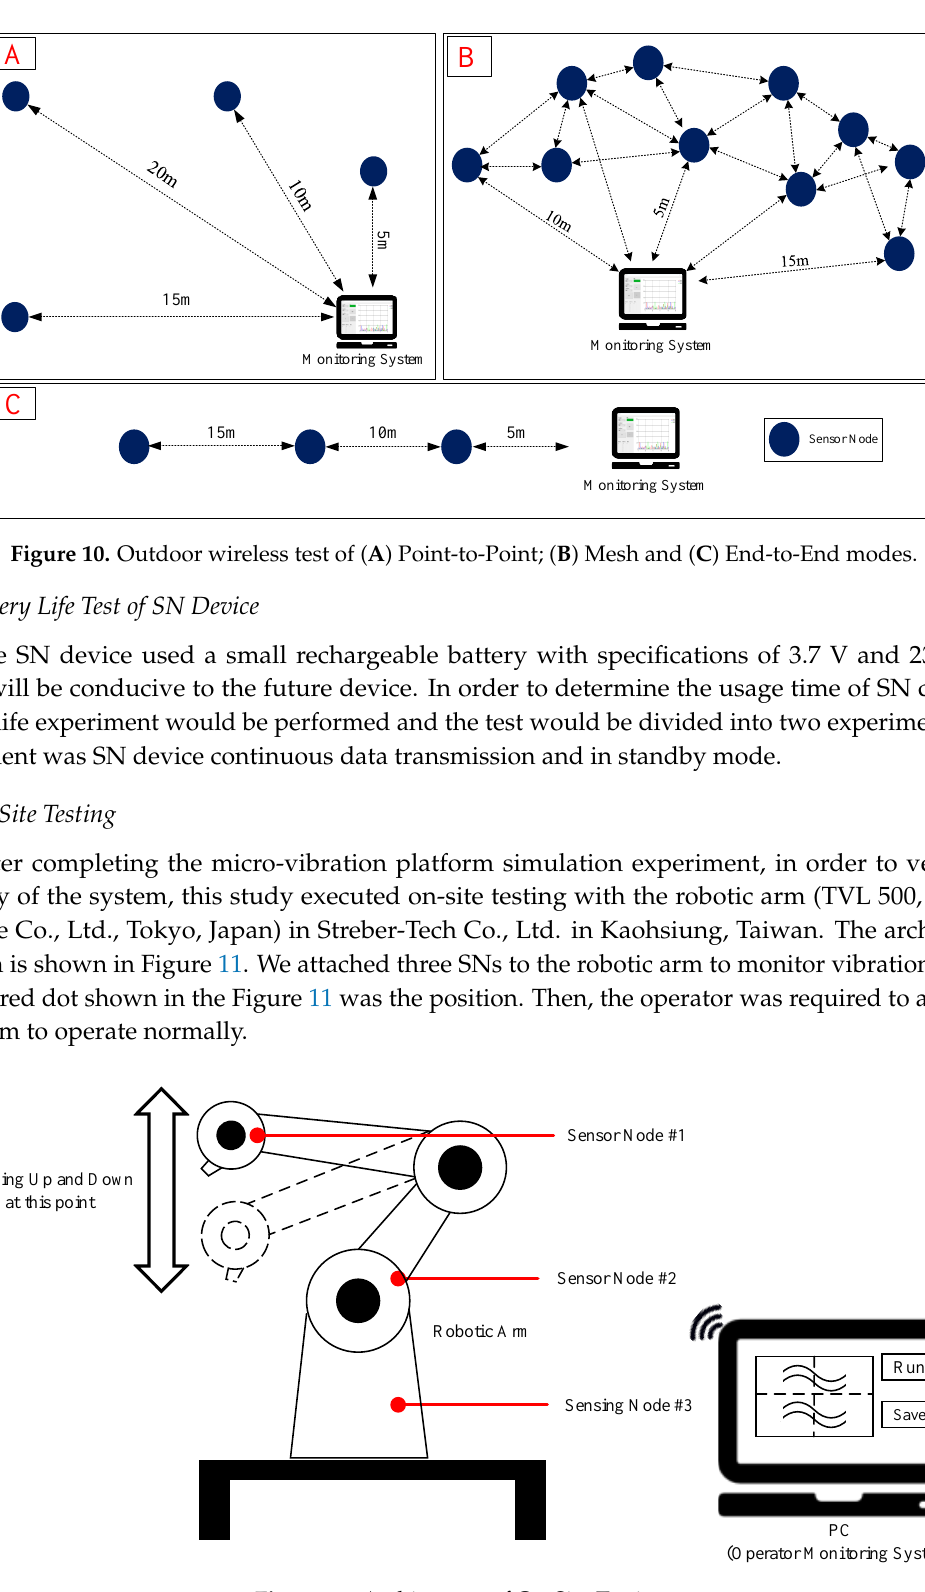
Figure 11. Architecture of On-Site Testing.